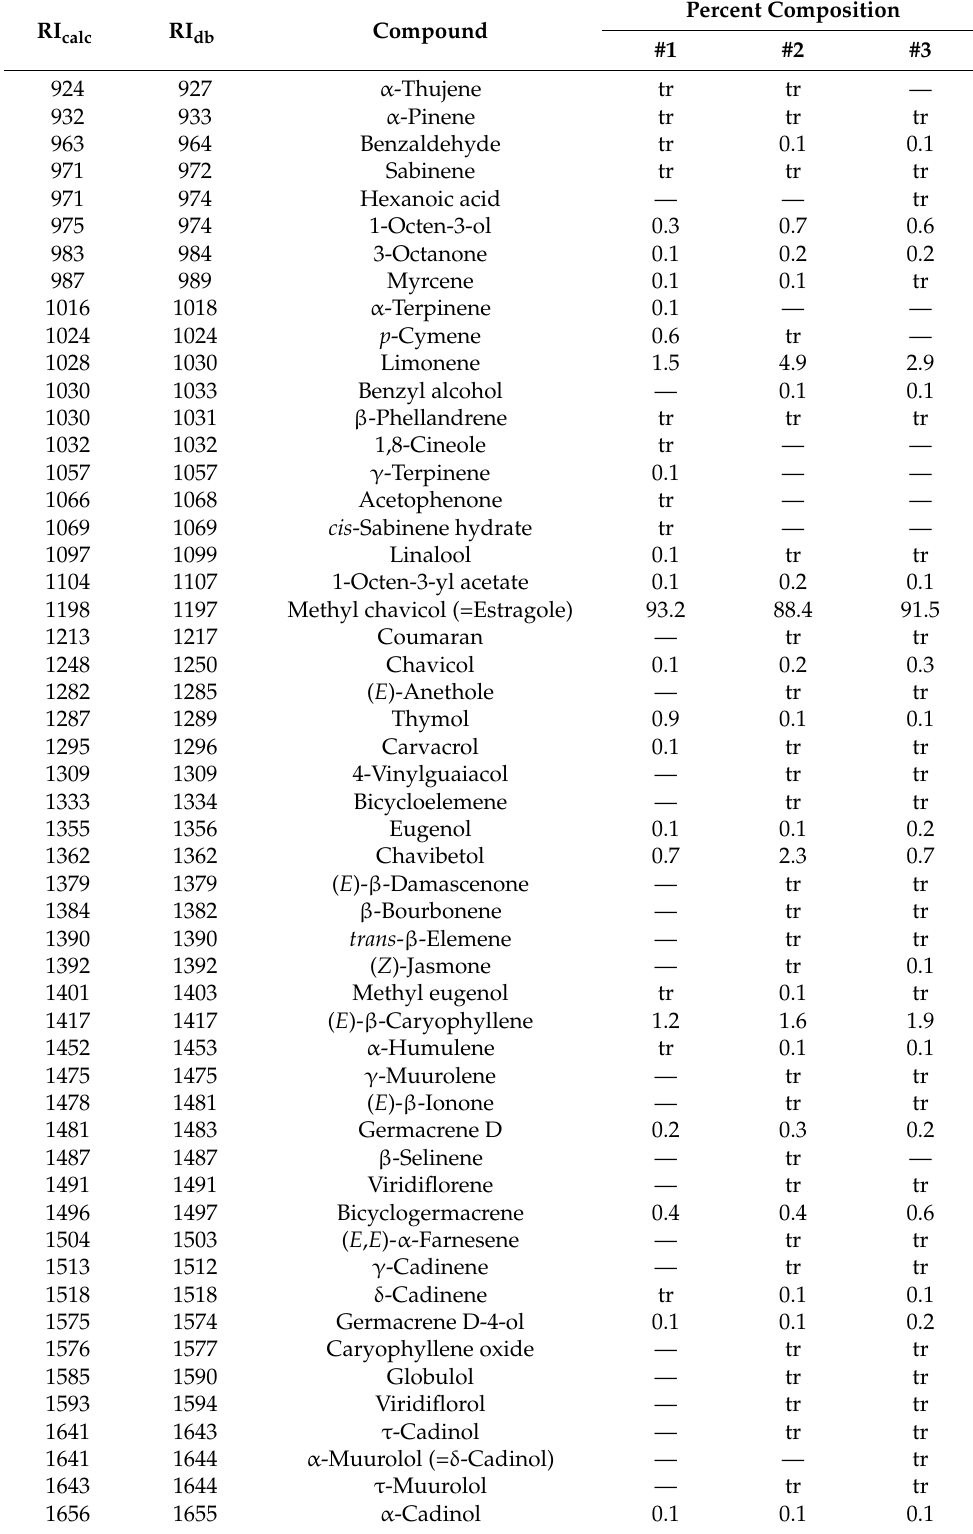
Table 2. Essential oil composition of three samples of anise fennel ( Agastache foeniculum ) cultivated in south